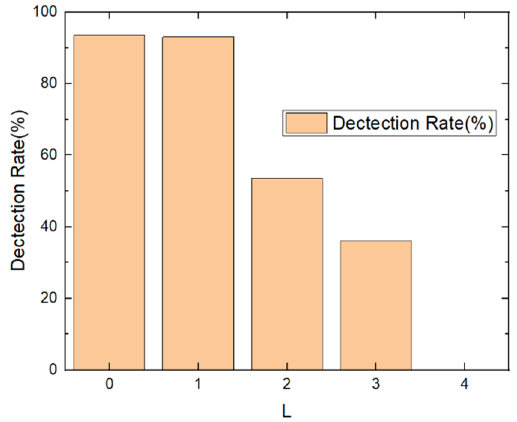
Figure 7. Adversarial Attack Results.